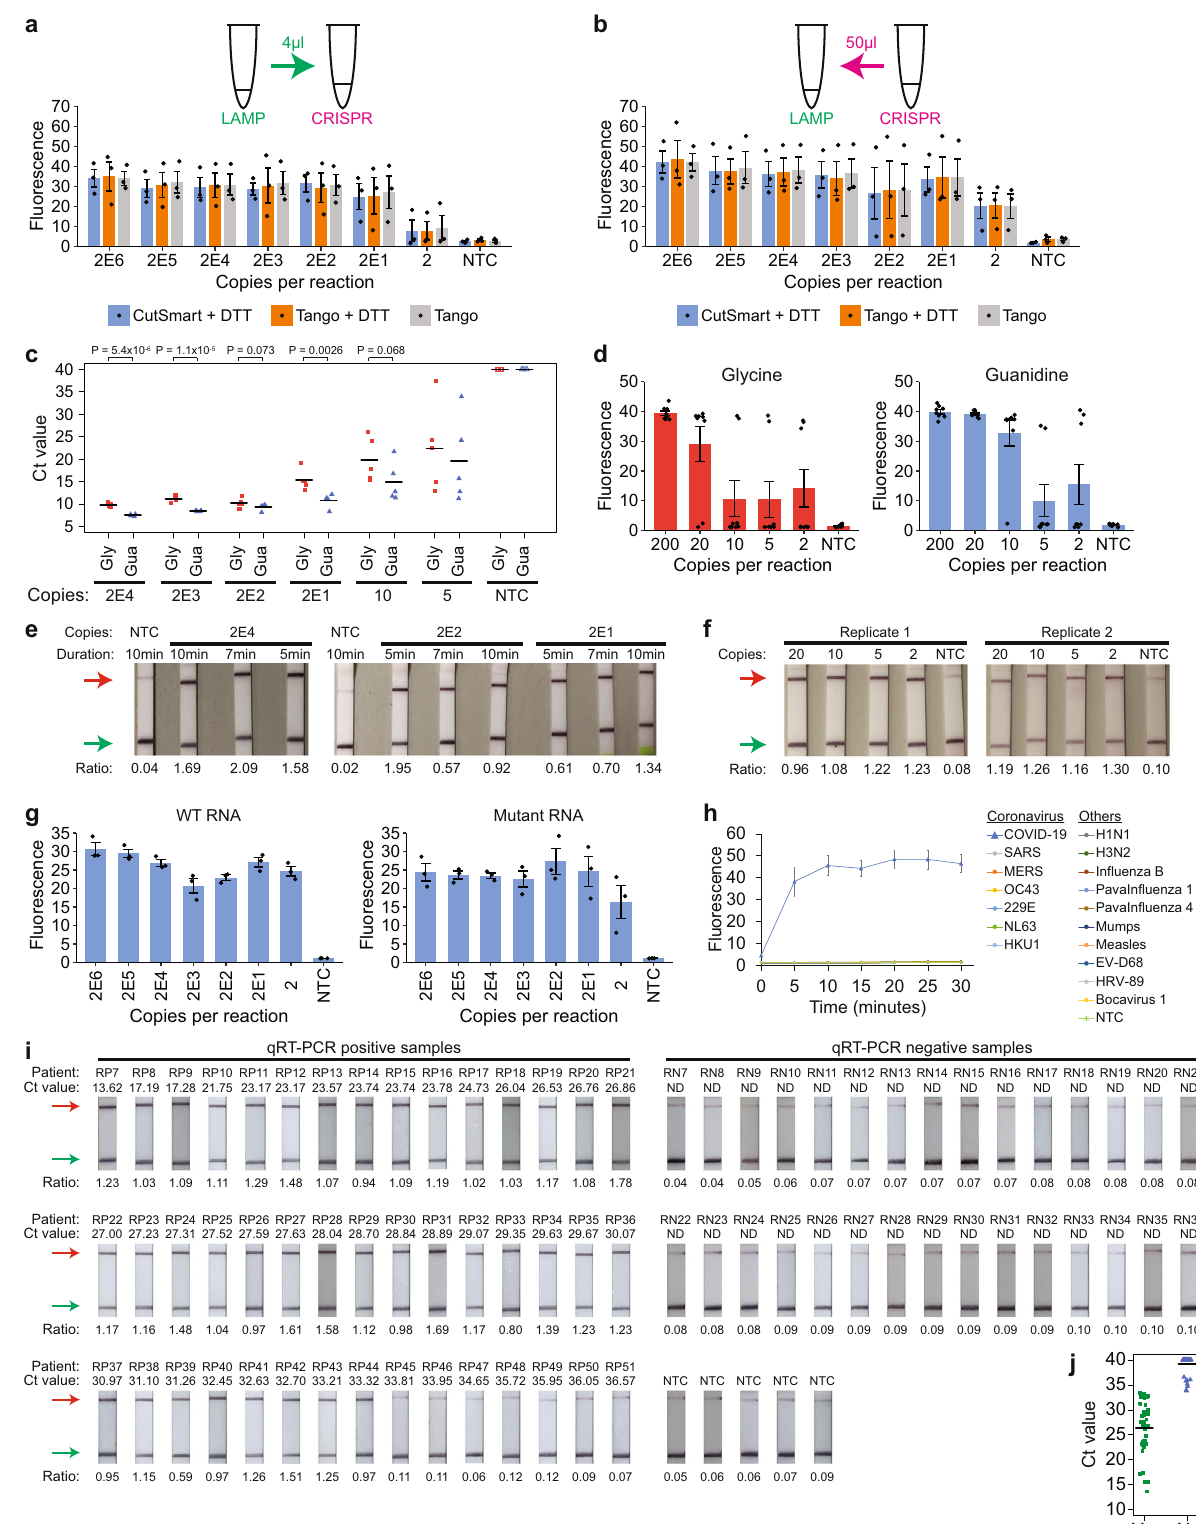
InfluenzaB PavaInfluenza1 PavaInfluenza4 Mumps Measles EV-D68 HRV-89 Bocavirus 1 NTC